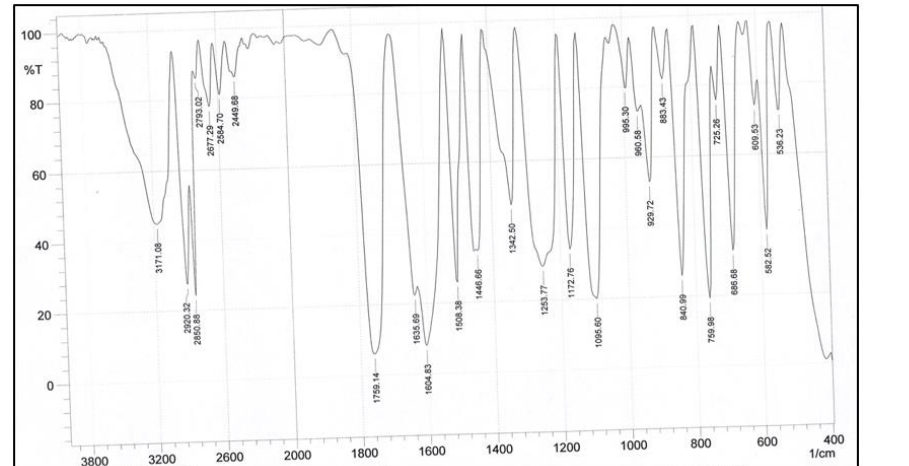
Fig. 9. FT- IR spectrum of PI polyester ʋ ( cm- 1 )